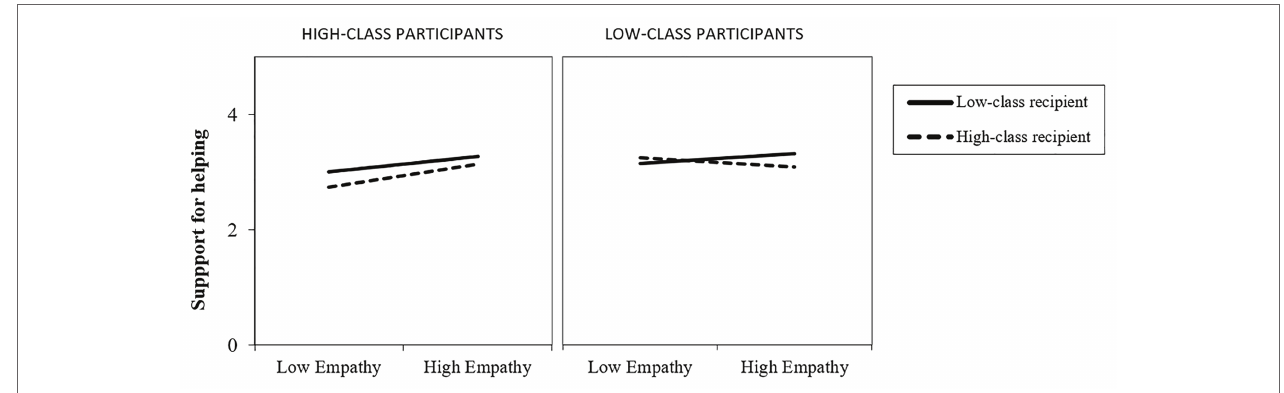
FIGURE 1 | Participant’s support for helping by high and low levels of empathy, as a function of the social class of the recipient of